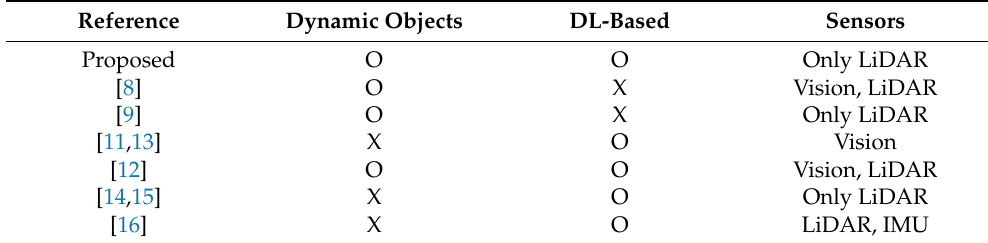
Figure 1. An example of the accuracy degeneration of SLAM in dynamic environments ( a ) SLAM in dynamic environments; ( b ) SLAM in static environments. Table 1. The comparison of related works.